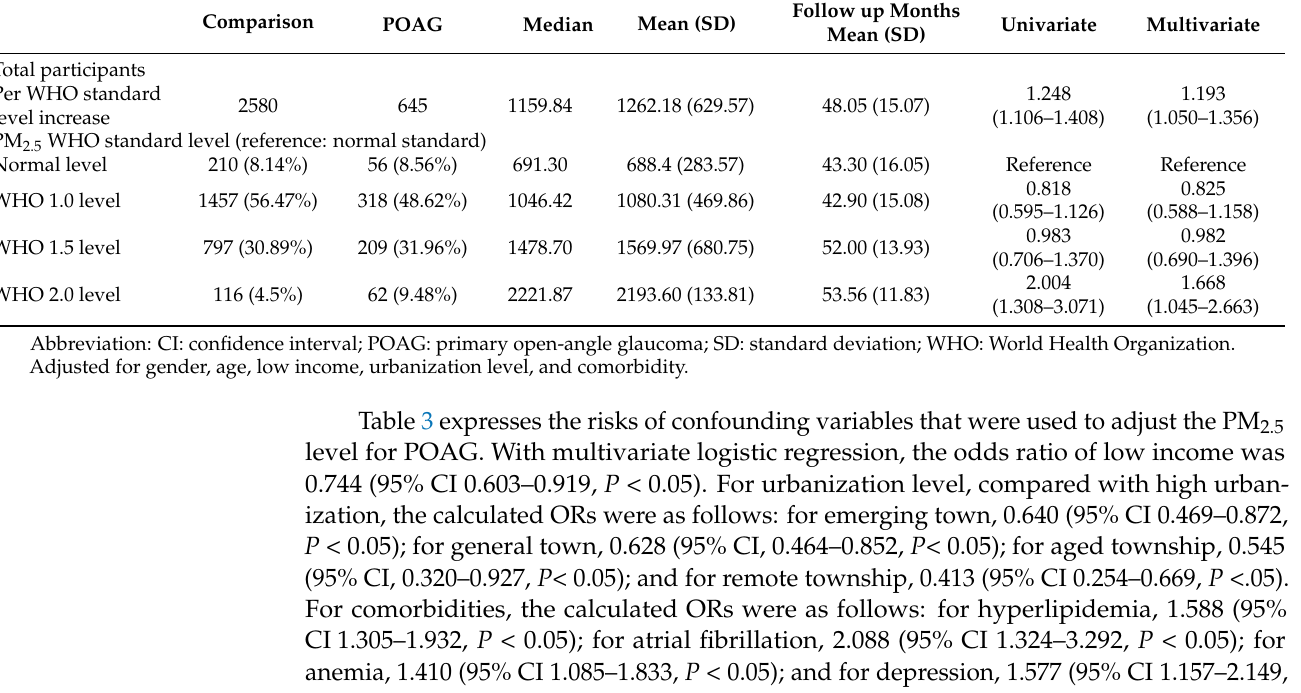
Table 2. Logistic regression analysis of particulate matter (PM) 2.5 level and POAG.